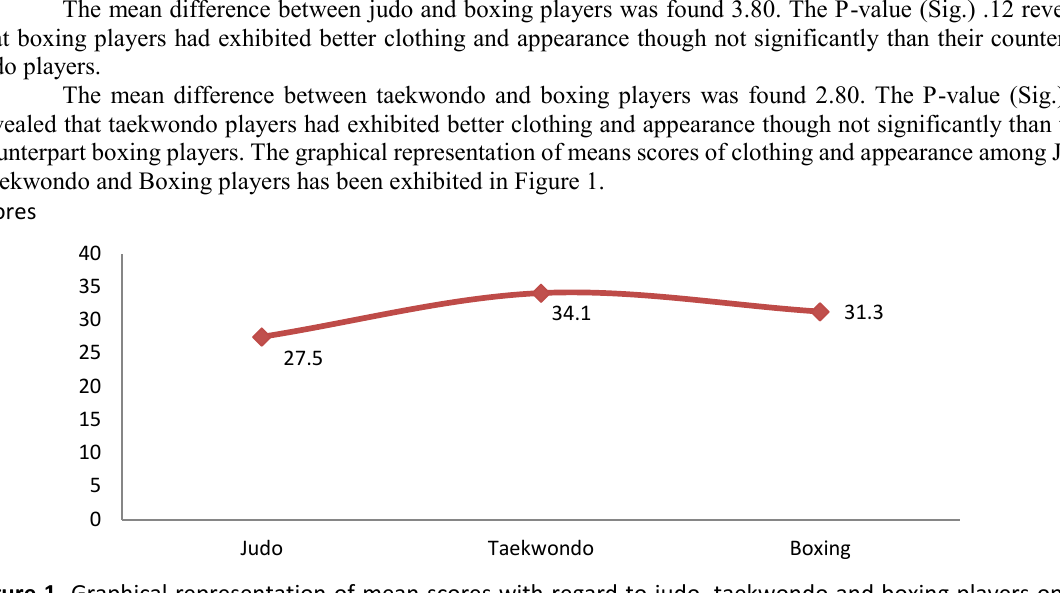
Figure 1. Graphical representation of mean scores with regard to judo, taekwondo and boxing players on the sub-parameter clothing and appearance Table 4. Descriptive analysis among judo, taekwondo and boxing players on the sub-parameter fetish S. No.